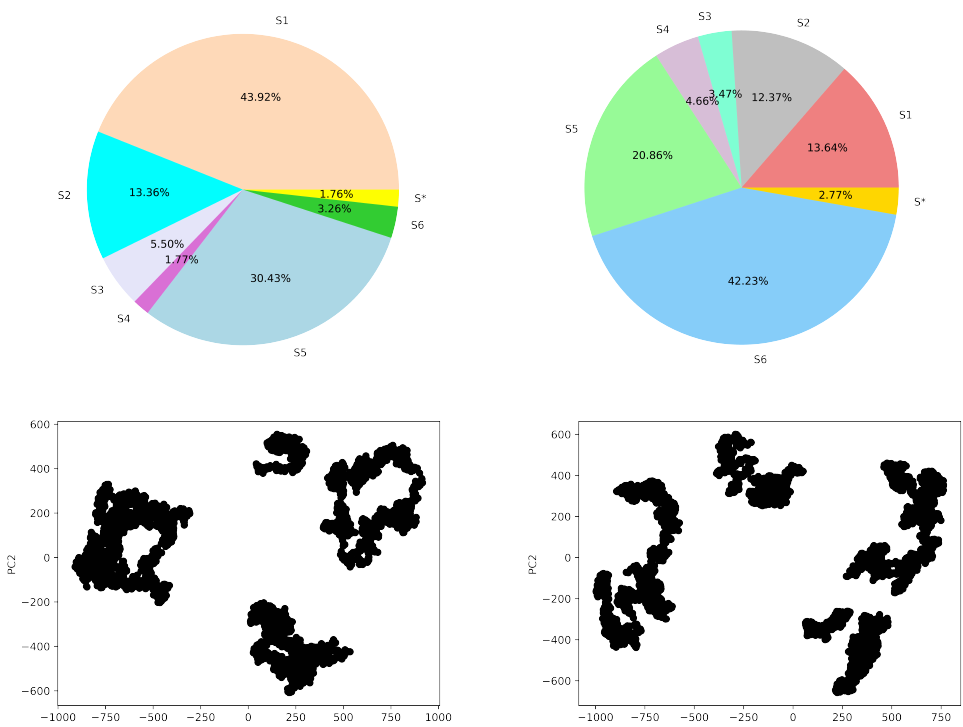
Figure 6. Top panel shows adjusted state populations for the ( left ) free-antibody and ( right ) antigen- bound antibody via the stationary distribution for the six top-populated macro-states, with the other states accumulated in S*. The bottom panel relates the embedding of the MD structures over the top two PCs.